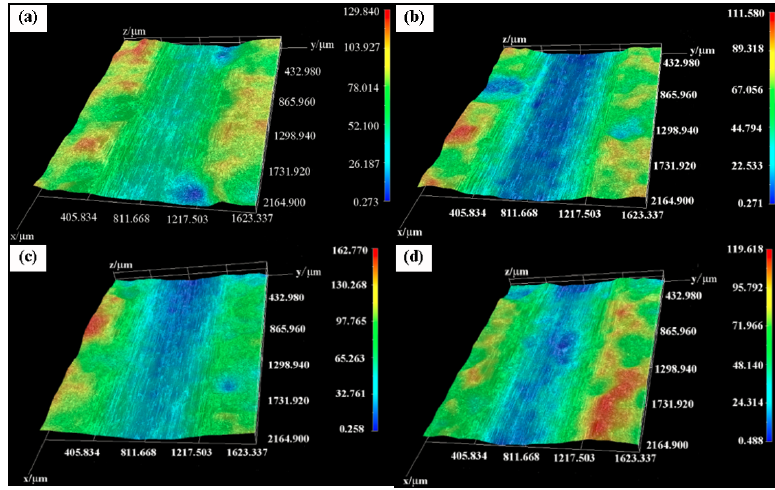
Figure 11. Three-dimensional morphology of the worn surfaces of the composite coatings with various Ni powder contents: ( a ) 10 wt %, ( b ) 15 wt %, ( c ) 20 wt % and ( d ) 25 wt %.